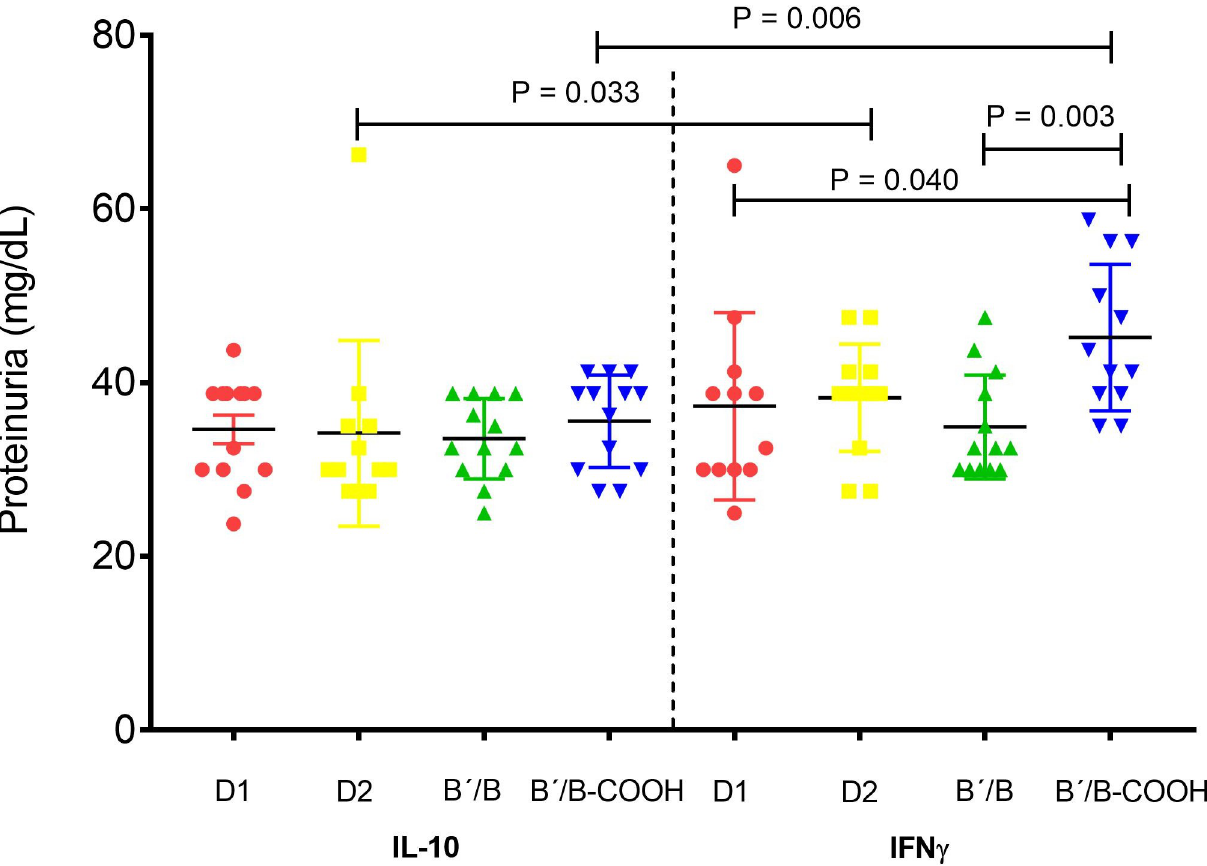
Fig 5. Prevalence of proteinuria in pristane-treated mice vaccinated with Sm antigens co-vaccinated with IL-10 vs . IFN- γ . Prevalence of proteinuria in pristane-treated mice vaccinated with Sm antigens co-vaccinated with IL-10 vs . IFN- γ . Each symbol represents one mouse. Mann-Whitney test was